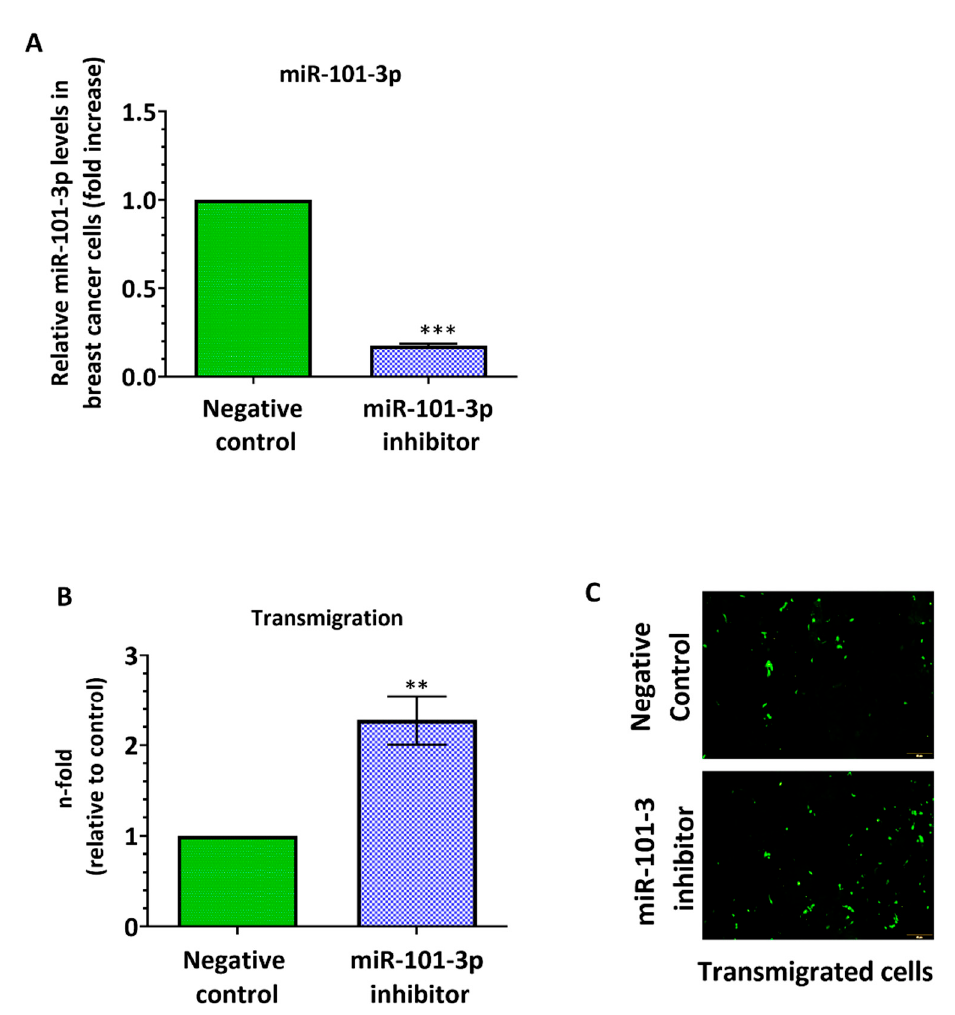
Figure 2. Ectopic downregulation of miR-101-3p in breast cancer cells promotes their transmigration through the brain endothelium. MDA-MB-231-TGL cells were transfected with miR-101-3p inhibitor (30 nM final concentration) or with negative control. ( A ) Relative miR-101-3p level expression was measured by real time PCR from total RNA. The small nuclear RNA U6 was used as internal control. ( B ) The transmigration abilities of the different BC cells were examined by trans-endothelial migration assay. ( C ) Representative images of transmigrated fluorescently labelled MDA-MB-231-TGL (small green cells) in control and anti-miR-101-3p transfected cells. Data are mean ± SD from three independent experiments. * p < 0.05, ** p < 0.01, *** p < 0.001.